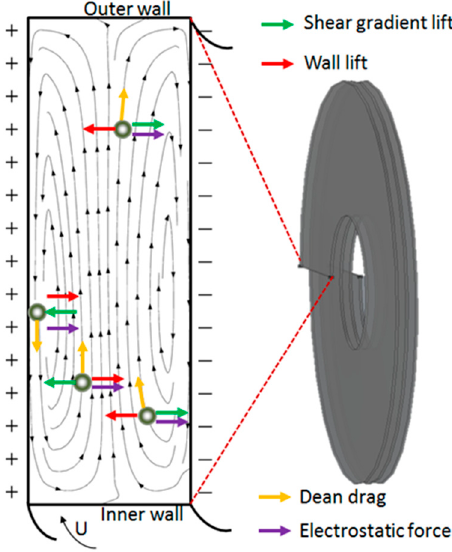
ff erent locations in the